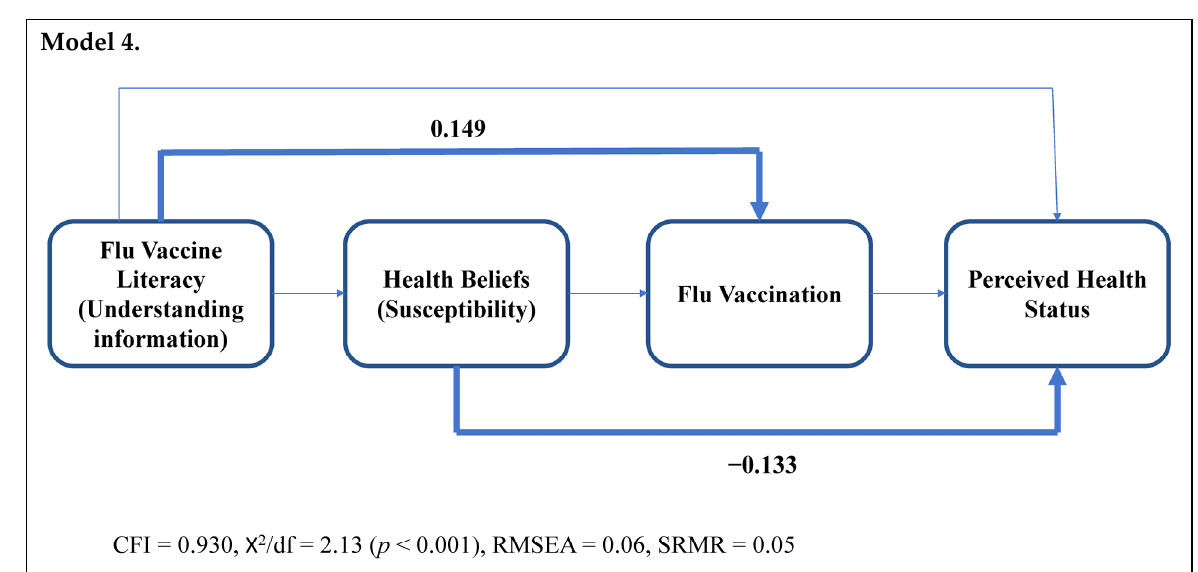
Figure 2. Effect of Flu Vaccine Literacy (i.e., understanding information) on Flu-related Health Beliefs, Flu Vaccination, and Perceived Physical Health Status. Note: Controlled factors: race, school year, gender, household income, and education attainment of the survey participants’ parents (mother and father); significant relationships were presented with boldlines; Sobeltest scores were presented for the models reporting the significant medication effects. −